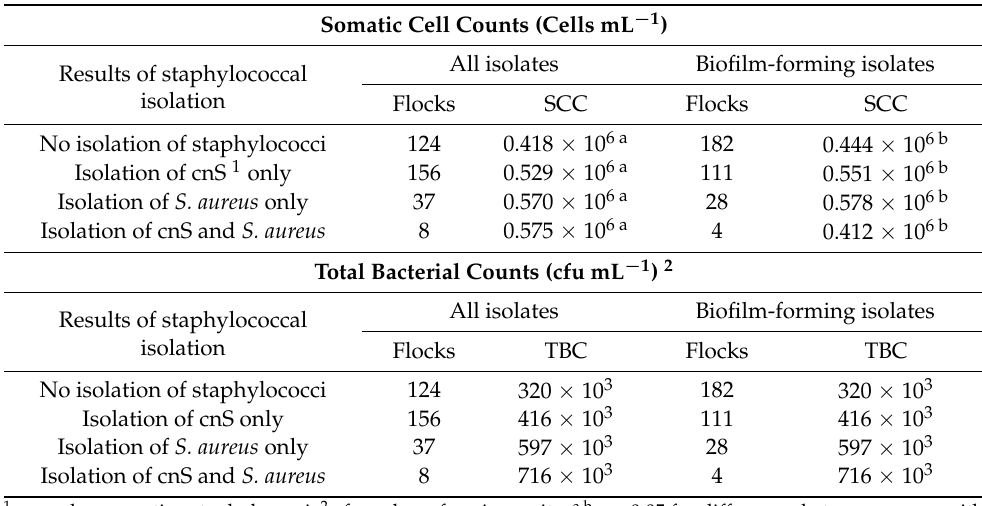
Table 3. Mean geometric somatic cell counts and total bacterial counts in bulk-tank milk of 325 sheep flocks in Greece, in accord with staphylococcal isolation from